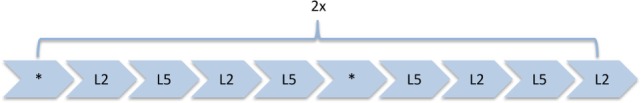
Sternberg WM task: task design. Four blocks of each load (load 2 = L2, load 5 = L5) alternating among baseline conditions (*). Each block contains four trials per load and was followed by a fixation of 2.5 s added to the ISI (+).